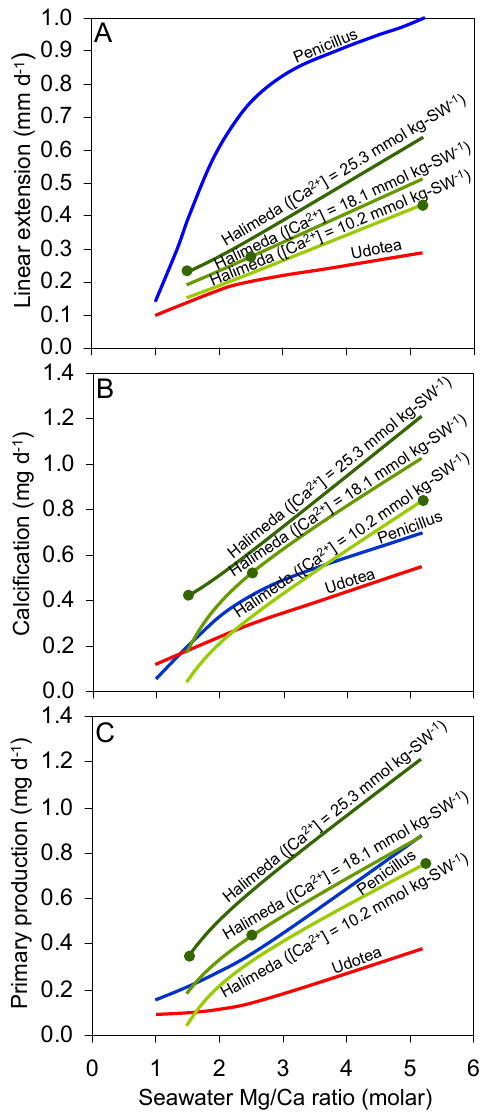
Fig. 7. Rates of linear extension (A) , calcification (B) , and primary production (C) for Halimeda incrassata (dark green curve: [Ca 2 + ]=25.3mmolkg-SW − 1 ; medium green curve: [Ca 2 + ]=18.1mmolkg-SW − 1 ; light green curve: [Ca 2 + ]=10.2mmolkg-SW − 1 ) , Penicillus capitatus (blue curve), and Udotea flabellum (red curve) algae reared in experimental seawaters of modified Mg/Ca and [Ca 2 + ]. Rates of linear exten- sion, calcification, and primary production increase significantly ( p < 0 . 05) for H. incrassata with both increasing seawater Mg/Ca ([Ca 2 + ] fixed) and increasing seawater [Ca 2 + ] (Mg/Ca fixed). Rates of linear extension, calcification, and primary production also increase significantly ( p < 0 . 05) with elevations in seawater Mg/Ca that are formulated with geologically realistic (Hardie, 1996; Demicco et al., 2005) reductions in [Ca 2 + ] for all three species of calcifying algae ( H. incrassata = closed green circles; P. capitatus = blue curve; U. flabellum = red curve). Primary production is calculated as total dry weight minus weight of CaCO 3 . Data from Ries (2005a, b, 2006a); Stanley et al.